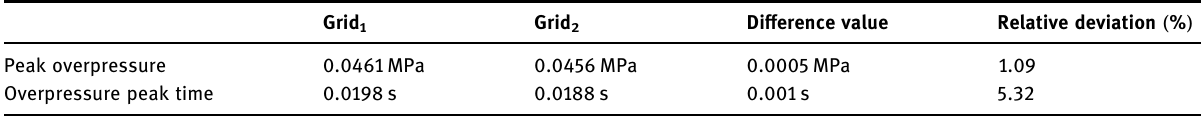
Table 4: Computation of peak explosion overpressure with Grid 1 and Grid 2 grids and their time